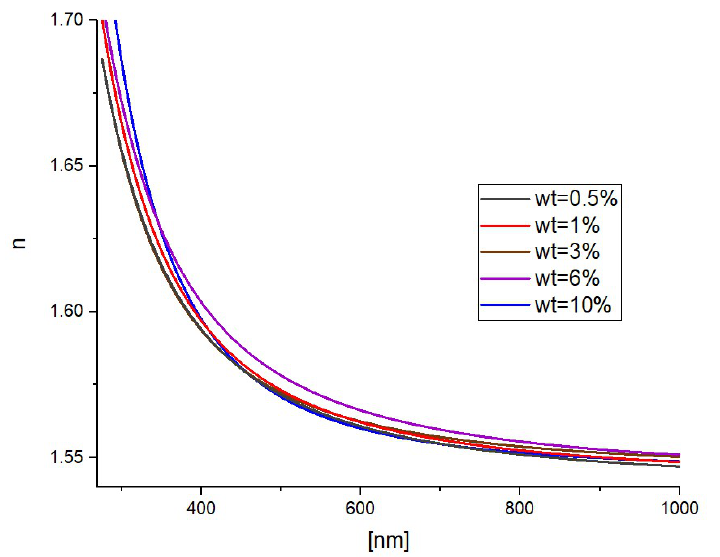
Figure 3. Refractive index (n) dependence on PSAN concentration as a function of